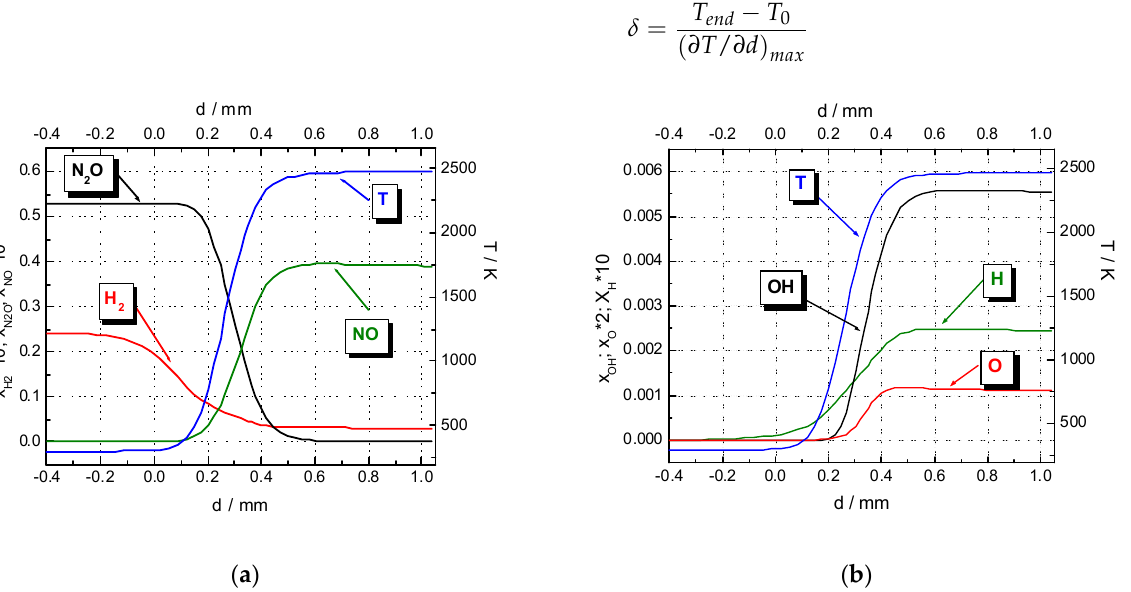
Figure 1. Temperature and mass fraction profiles of representative species in the flame front of a N 2 –diluted stoichiometric H 2 –N 2 O flame under ambient initial conditions (N 2 = 40 vol%): ( a ) H 2 , N 2 O and NO; ( b ) H, OH and